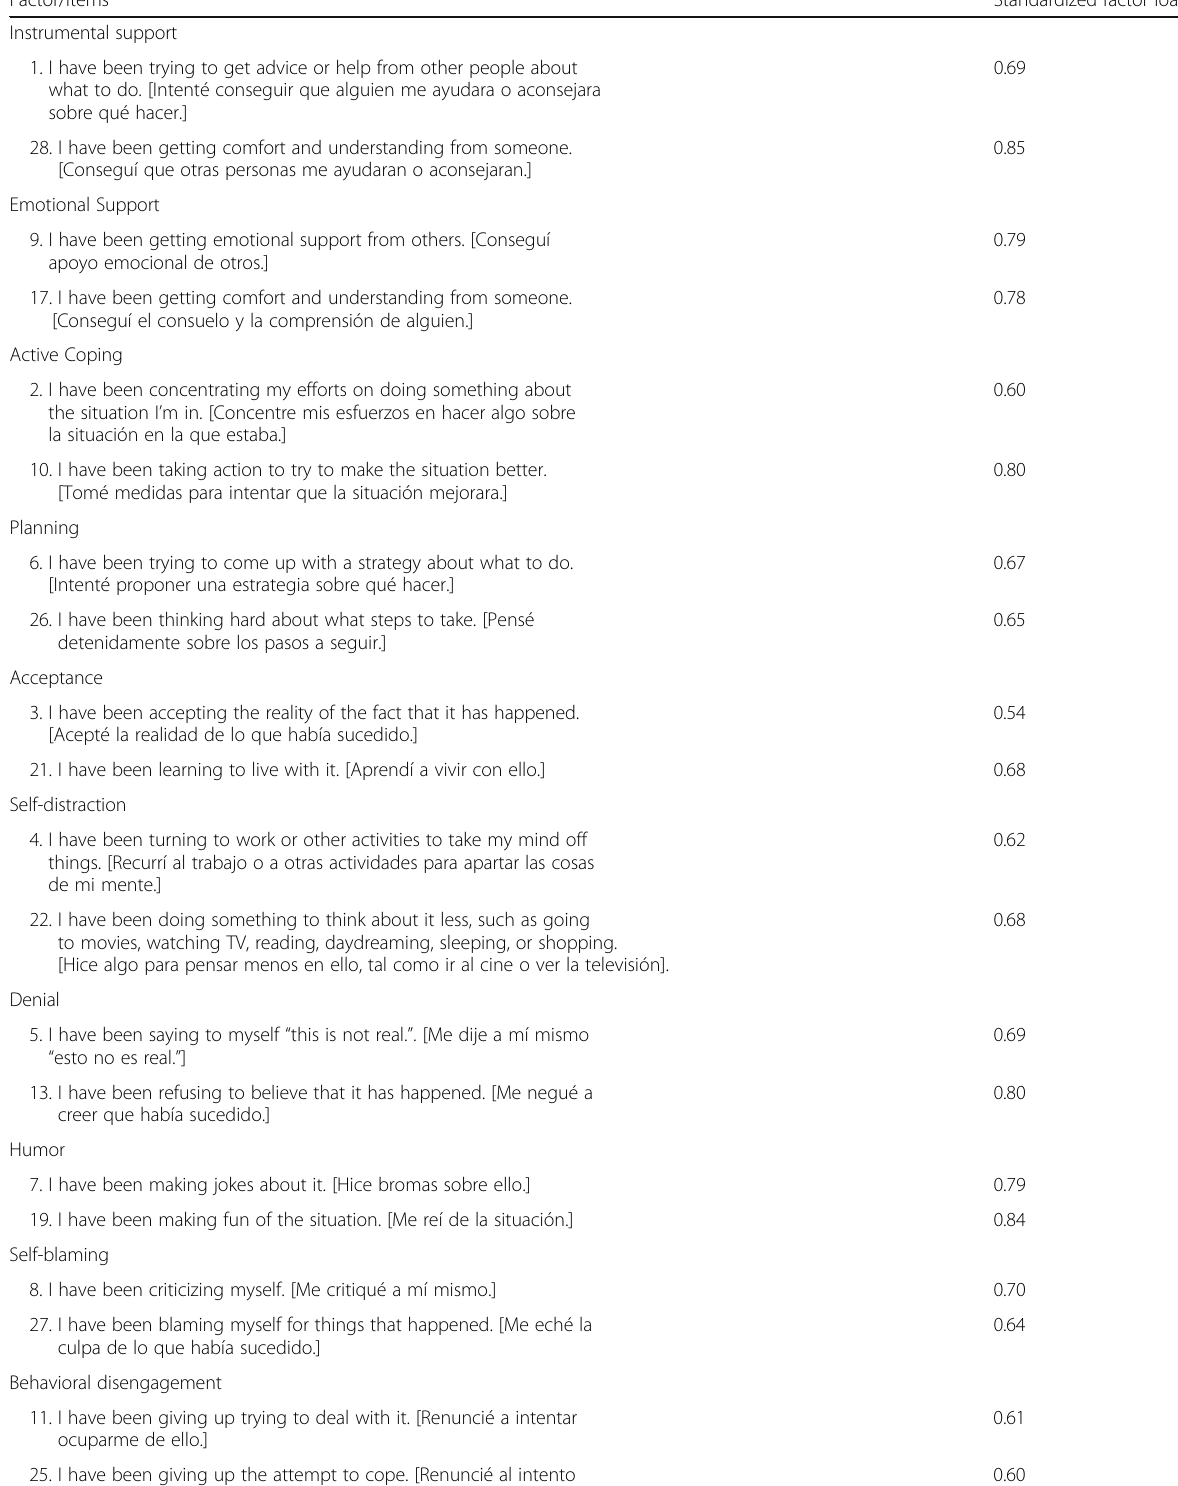
Table 3 Factors, items, and standardized factor loadings for model 1 ( n =